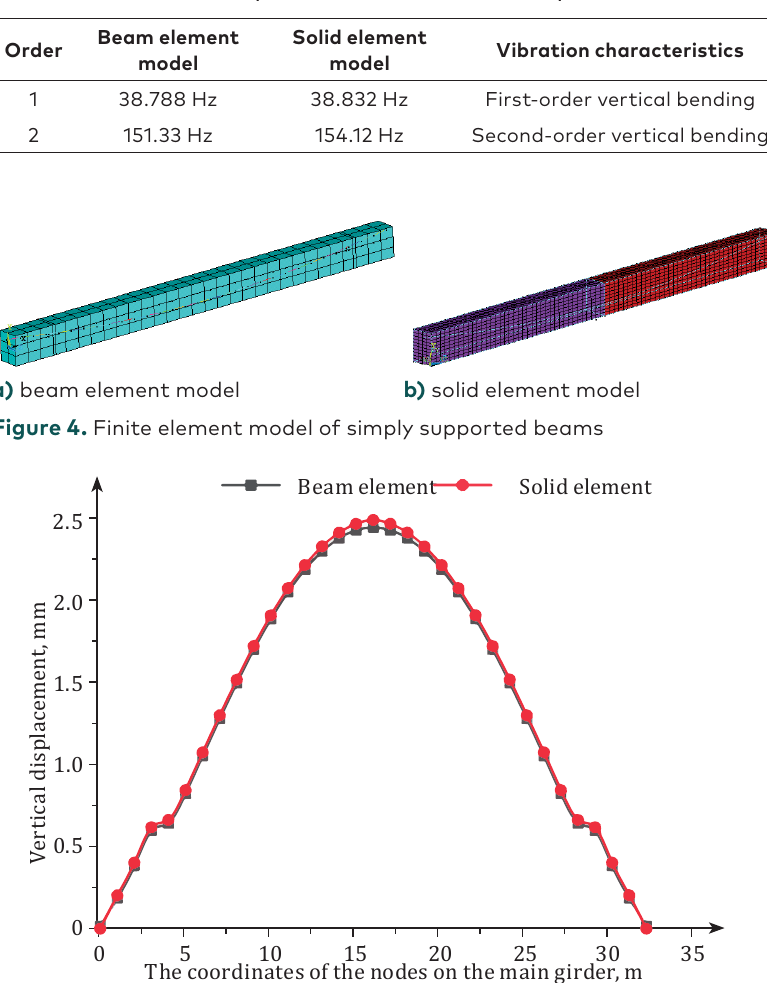
Table 1. Comparison of vertical natural frequencies of two